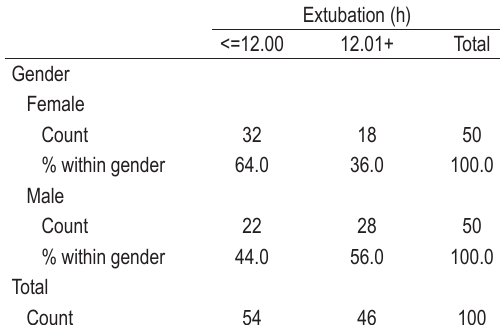
TABLE 1. Extubation and demographic data